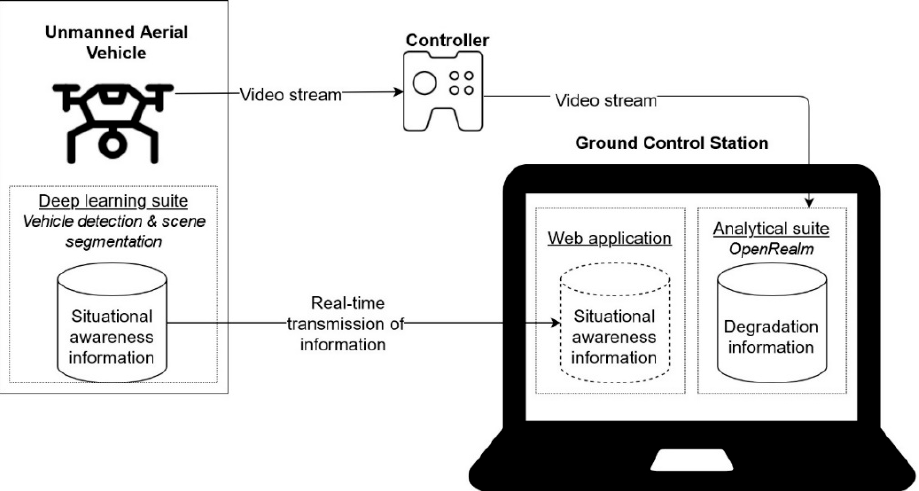
Figure 1. Method overview of the designed UAV monitoring system showing where each module is situated and how the processing pipeline functions during a UAV mission.